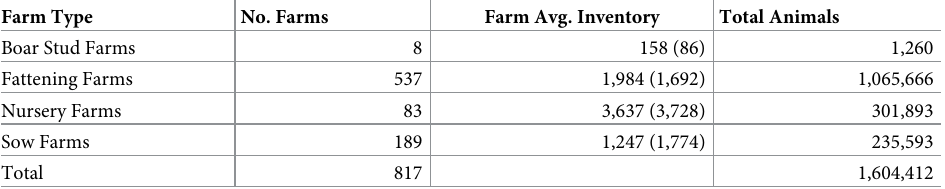
Table 1. Inventory distribution per farm type in the RCP-N212